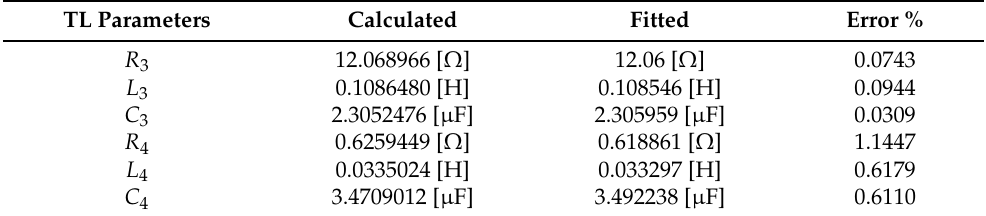
Table 8. The calculated and fitted parameters of the proposed model for Z 12 .